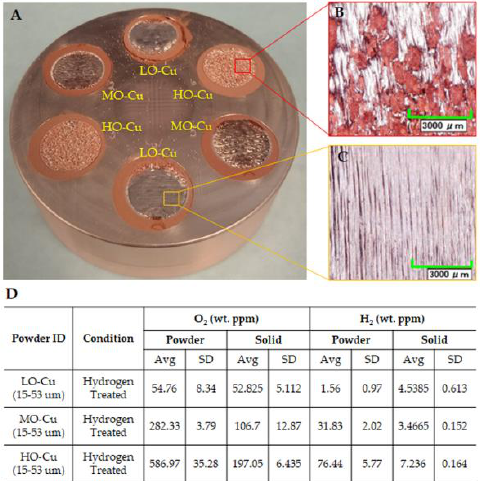
Figure 13. Photograph showing the oxygen free electronic (OFE) copper fixture after EB-PBF of single layer discs on top of hydrogen-treated powder cakes ( A ). Optical microscope images of the surface of single layer disc produced with hydrogen-treated HO-Cu showing pitting and porosity ( B ), and surface of single layer disc produced with hydrogen-treated LO-Cu, showing a smooth surface texture ( C ). Tabulated oxygen and hydrogen contents of the precursor powders and the solid single layer discs for each treated powder condition ( D ).